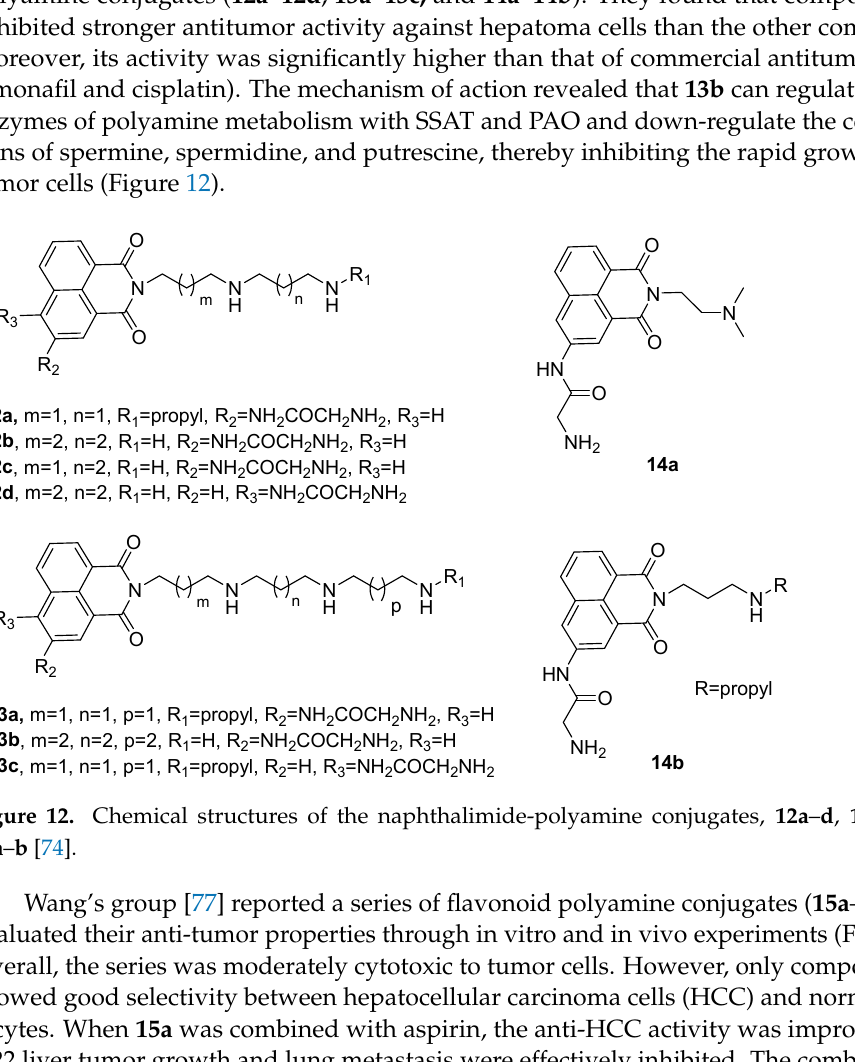
Figure 14. Chemical structures of the naphthoquinone ‐ polyamine conjugates, 16a – 16c [81]. 3.2. Combinations Target Multiple Components Due to compensatory mechanisms, the single agents have failed to obtain satisfactory clinical effects. For example, increased polyamine uptake from the surrounding microenvironment is involved if polyamine synthesis is limited. The increased polyamine catabolism leads to an increase in the activity of the ODC polyamine biosynthetic enzyme. When polyamines are depleted in cells, the ODC expression levels are increased. A combination strategy combining two or more agents is more promising for cancer chemoprevention because the agents work synergistically, with decreased adverse effects. For example, “polyamine blocking therapy (PBT)” by a combination of polyamine biosynthesis and transport inhibitors can lead to efficient polyamine depletion. The combination of DFMO and catabolism inducers has shown enhanced antitumor activity. 3.2.1. Spermine ‐ Responsive Supramolecular Chemotherapy Supramolecular chemotherapy is devoted to utilizing supramolecular approaches to reduce the cytotoxicity of chemotherapeutic drugs and enhance their anticancer activity. The use of macrocyclic host molecules can encapsulate clinical anticancer drugs and reduce their toxicity to normal cells. Upon entering the polyamine multi ‐ expression environment, the polyamine can competitively combine with the macrocyclic host, thereby causing the release of anti ‐ tumor drug molecules. Zhang and co ‐ workers developed supramolecular chemotherapy based on cucurbit[n]uril and an antitumor drug [85–87]. Upon competitive replacement by spermine, the recovery of the antitumor activities of drugs was obtained. For example, the host − guest complex of dimethyl viologen (MV) ‐ CB[7] was added to tumor cells with overexpressed spermine; subsequently, the antitumor activity of MV can be recovered by the competitive replacement of spermine [85]. When another clinical drug, oxaliplatin, was used as a model antitumor agent, the oxaliplatin ‐ CB[7] complex exhibited more cooperatively enhanced antitumor activity than oxaliplatin itself (Figure 15) [86]. The